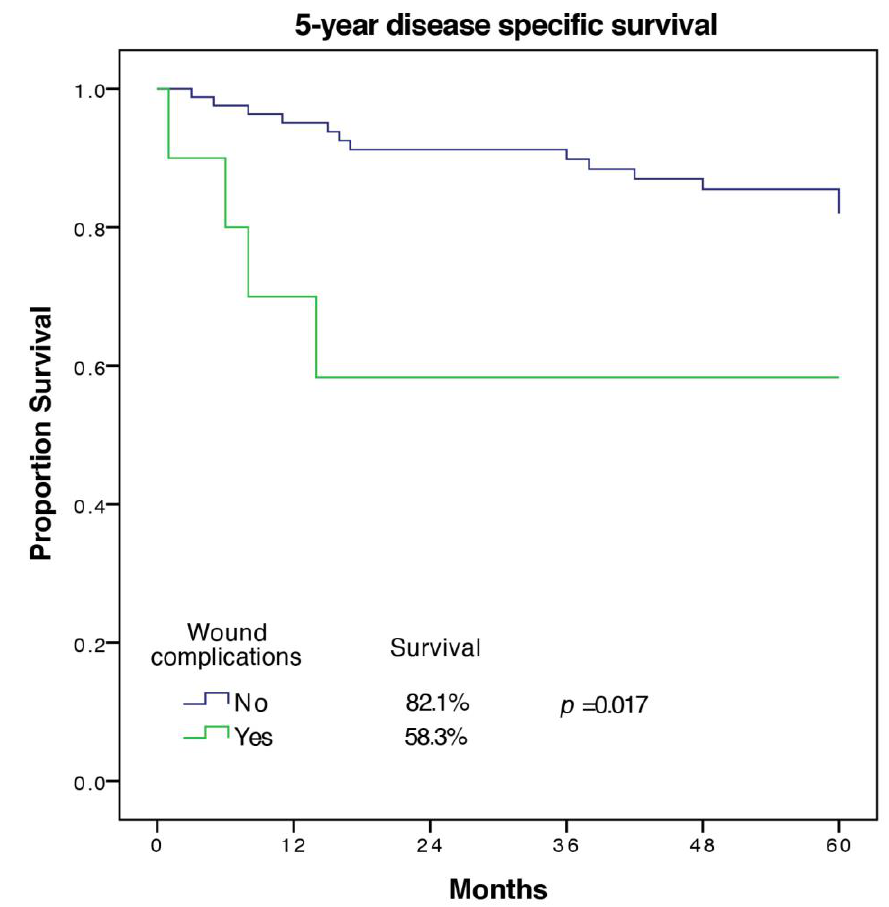
Figure 3. 5-year disease specific survival of patients with and without wound complications.